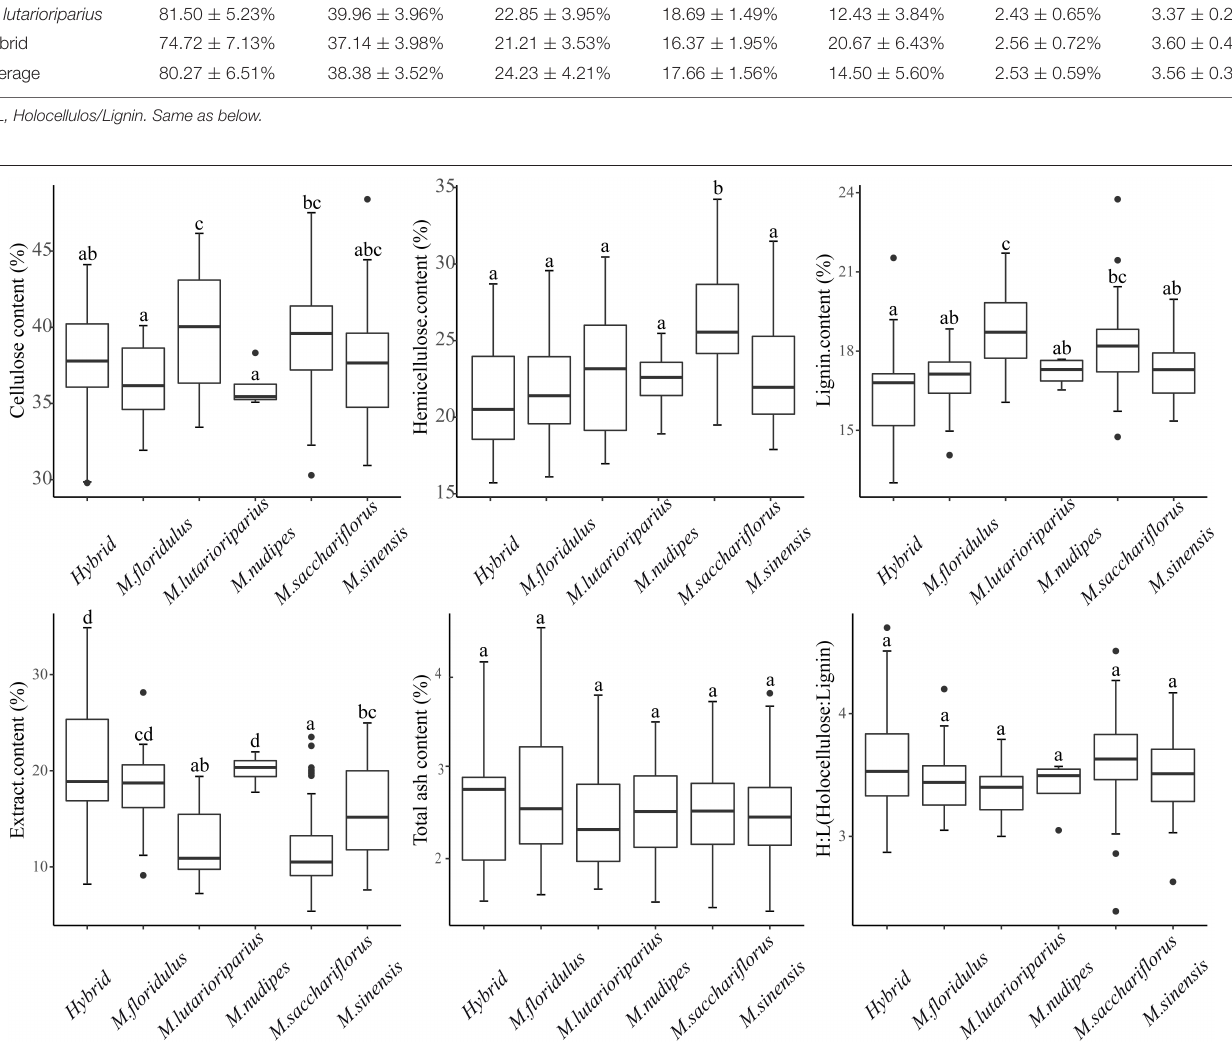
and 2.53 ± 0.59%, respectively. The average